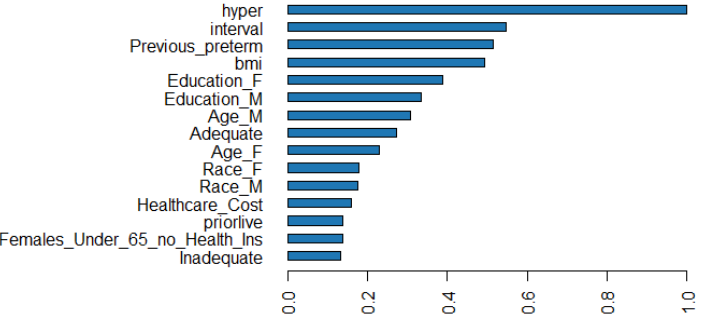
Figure 6. Variable Importance Plot. Table 5. The Top 15 Variables in Prediction of Preterm